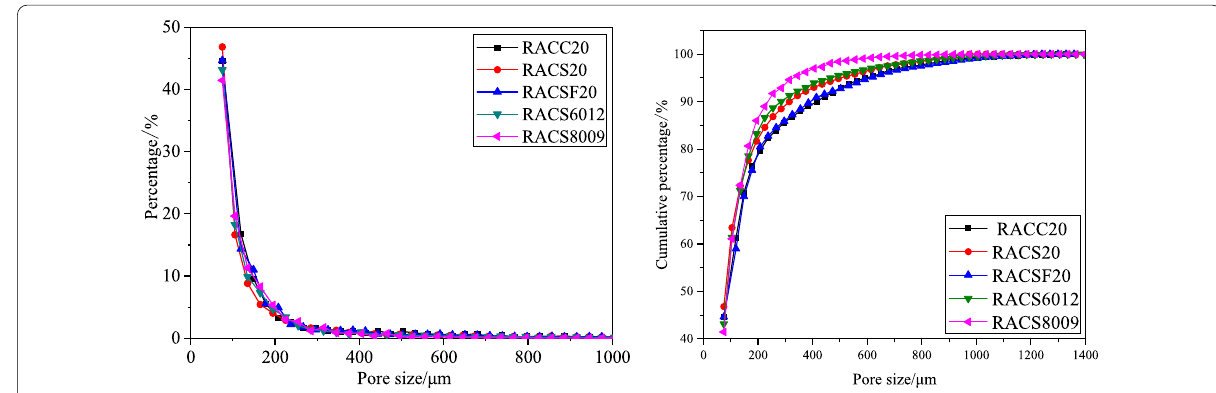
Fig. 7 Influence of admixtures and curing conditions on pore size distribution